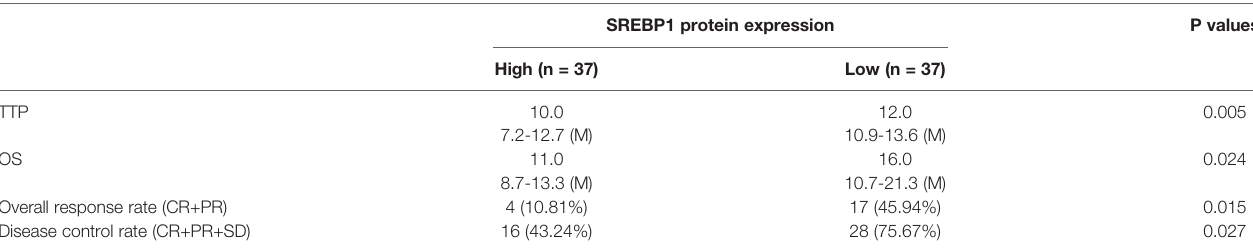
TABLE 1 | SREBP1 expression and clinical outcome of sorafenib treatment.